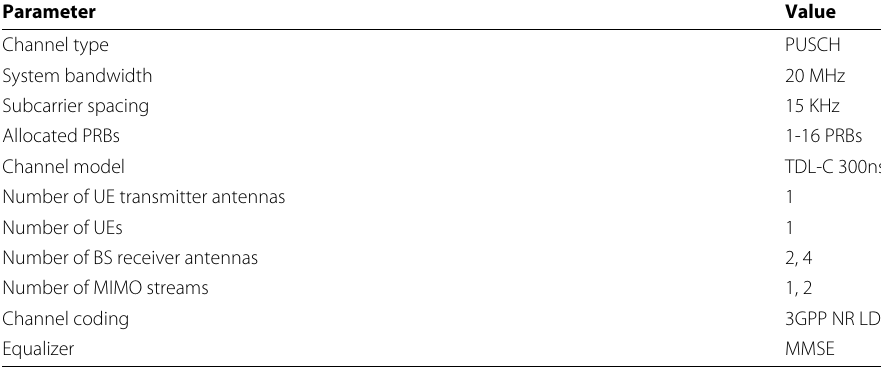
Table 2 Simulation assumptions for BLER comparisons